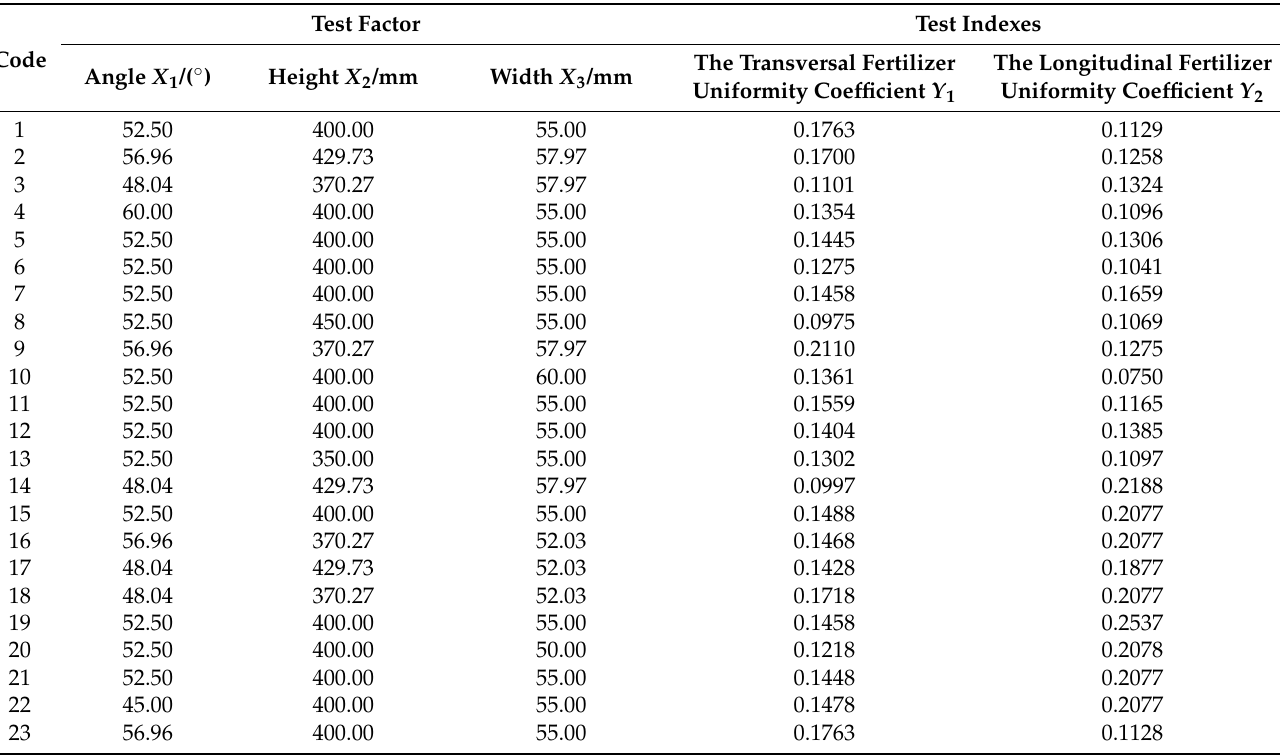
Table 4. Simulation test scheme and results.